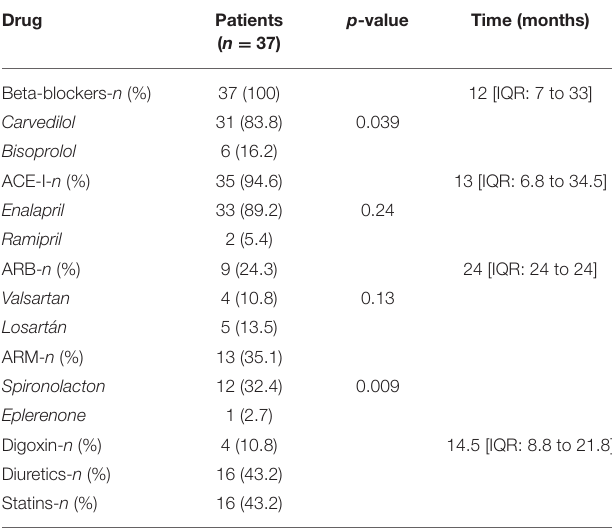
TABLE 4 | Maintenance of cardiac treatment in the patients with LVEF recovery after cancer therapy-related cardiomyopathy. Drug Patients ( n =